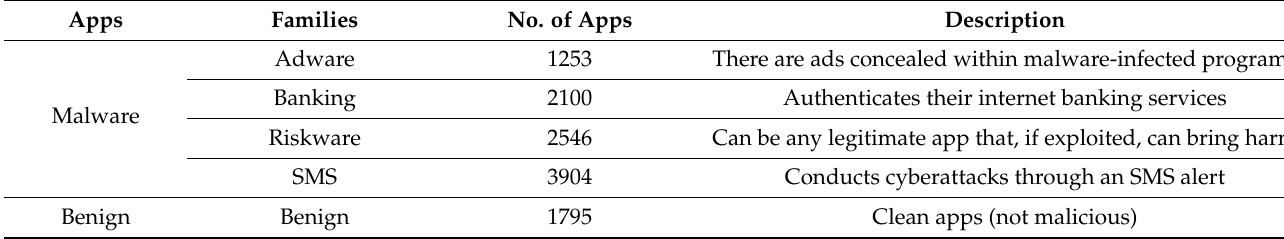
Table 2. CICMalDroid 2020 dataset (dataset